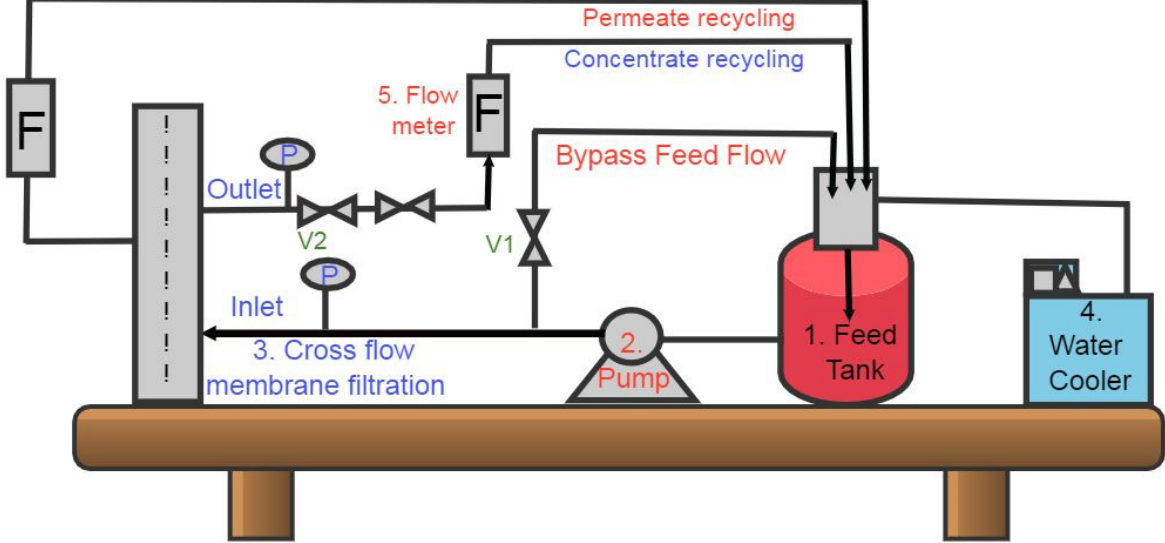
Figure 5. Diagram of membrane scaling experiments process flow.